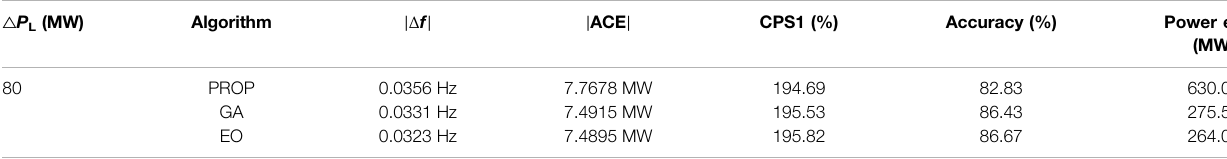
TABLE 4 | Result of